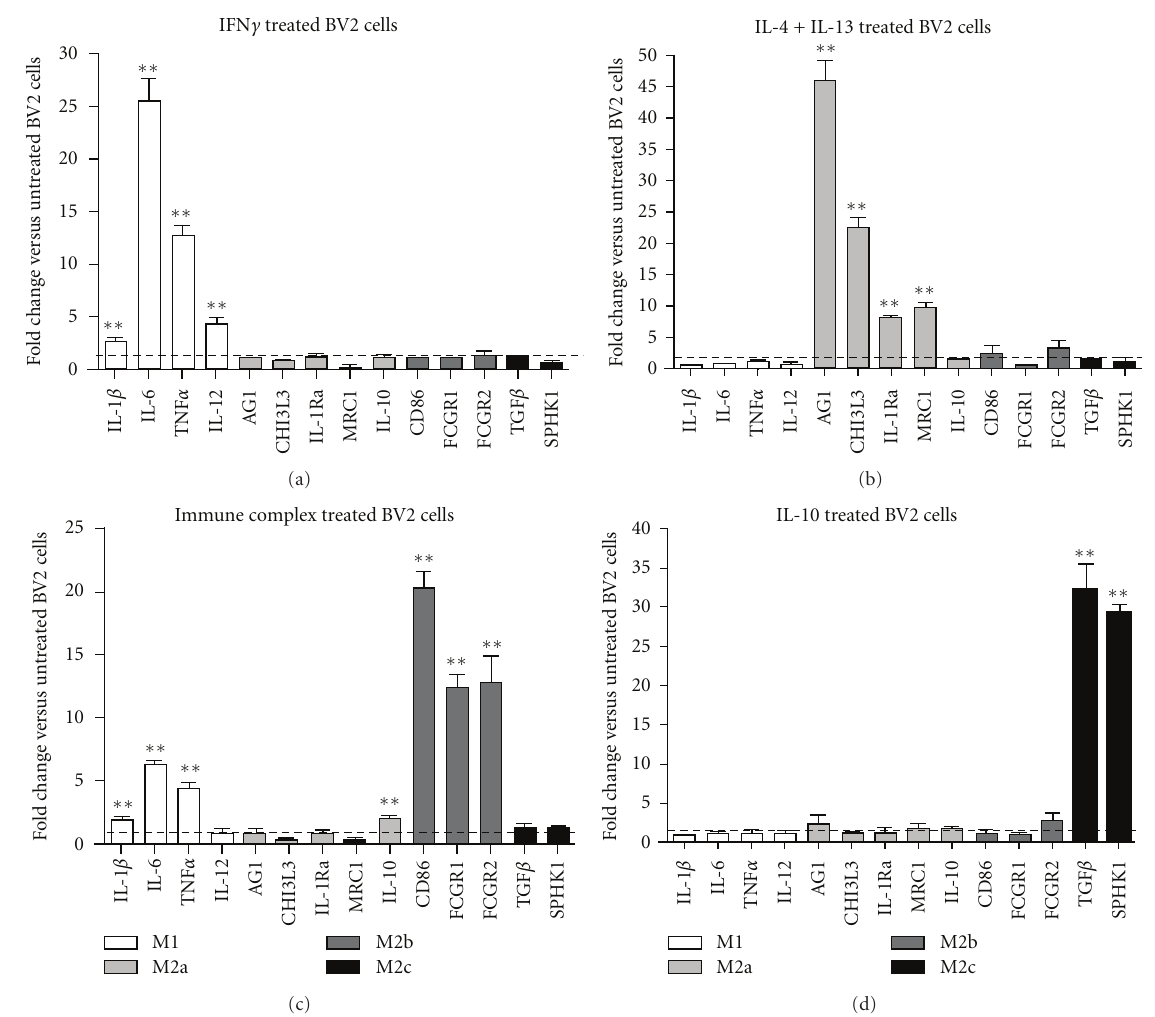
Figure 2: Stimulation of BV2 cultured microglial cells to polarize the response to M1, M2a, M2b, or M2c. BV2 microglial cells were cultured in normal DMEM media. When confluent, cell media was changed to serum-free DMEM media for 24 hours. Then media was changed to either DMEM plus IFN γ (2.5ng/mL) to stimulate an M1 response (a), DMEM plus IL-4 (20 ng/mL) and IL-13 (20ng/mL) to stimulate an M2a response (b), DMEM plus immune complexes prepared as described in [32] (5 μ g/mL A β coated with IgG) to stimulate an M2b response (c), DMEM plus IL-10 (10ng/mL) to stimulate an M2c response (d), or DMEM alone to act as an untreated control. Cells were then harvested 12 hours after the start of treatment. We repeated the experiments 3 times, each on separate cultures of di ff erent passage numbers. Data are shown as fold change compared to untreated control BV2 cells. ∗ P < 0 . 05 and ∗∗ P < 0 .